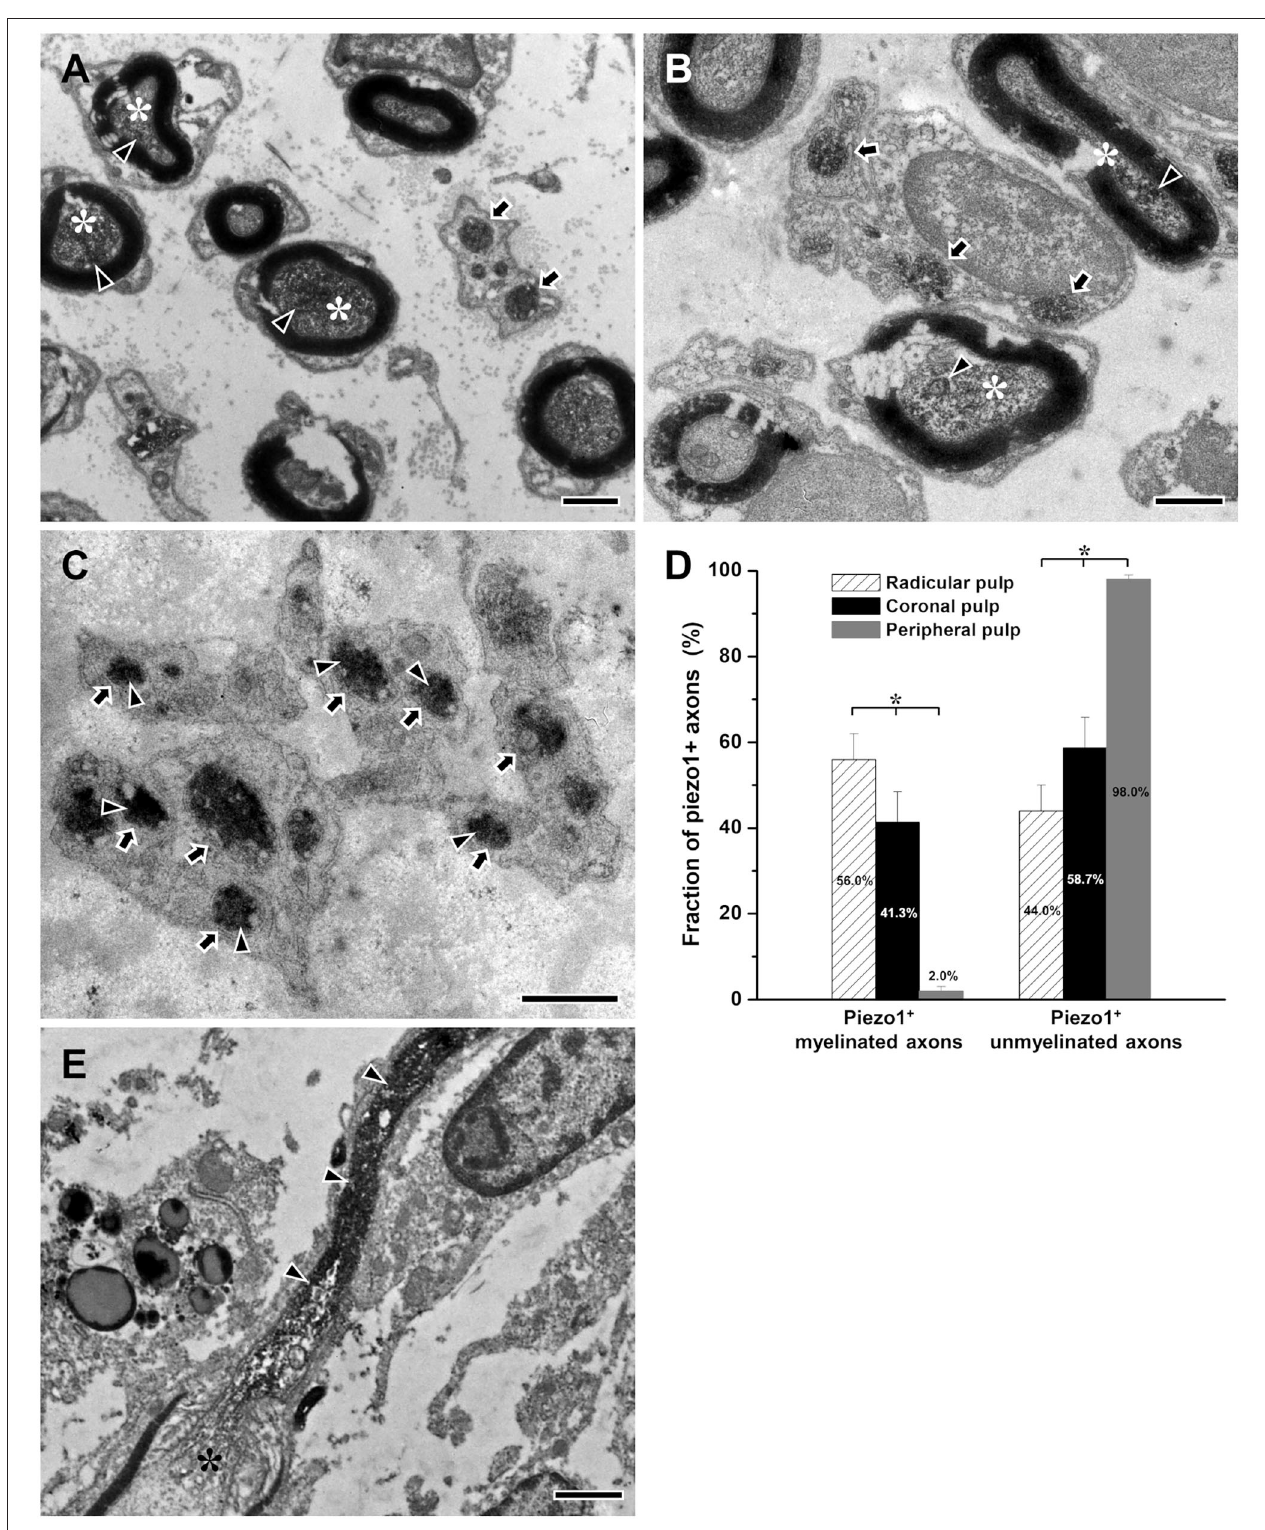
FIGURE 4 | Electron micrographs showing immunostaining for Piezo1 (arrowheads) in myelinated (asterisks) and unmyelinated axons (arrows) in the radicular (A) , the core of the coronal (B) , and the peripheral (C) regions of the human dental pulp, and a histogram showing the fraction of Piezo1 + myelinated and unmyelinated